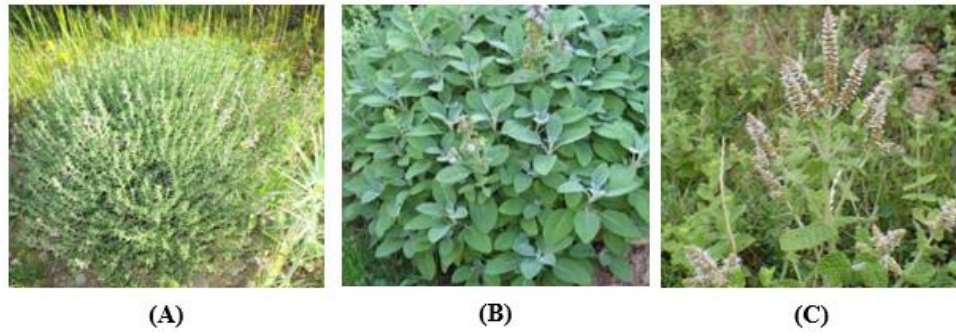
Figure 4. T. zygis L. ( A ), S. officinalis L. ( B ) and M. suaveolens Ehrh. ( C ).